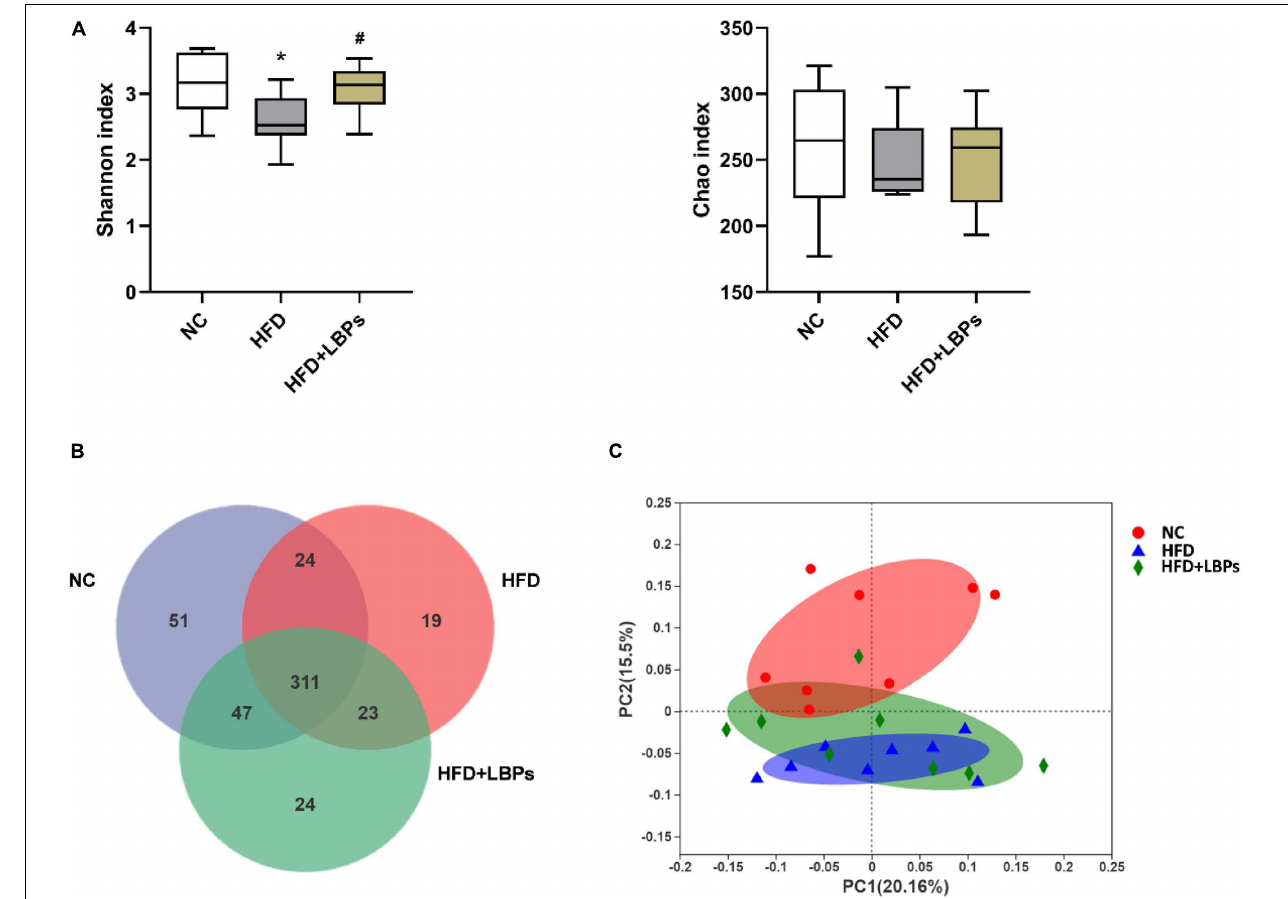
FIGURE 5 | Effects of Lycium barbarum polysaccharides (LBPs) on diversity of modulation of gut microbiota. (A) Alpha diversity analysis, including Shannon, and Chao index. (B) Venn diagram of OTUs. (C) Principal coordinate analysis plot of gut microbiota based on unweighted unifrac metric. * P < 0.05 vs. NC group and # P < 0.05 vs. HFD